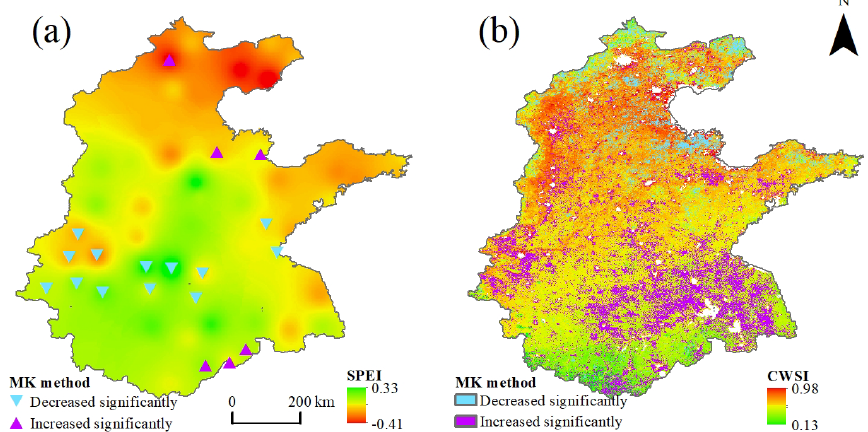
Figure 3. Spatial changes in the SPEI ( a ) and CWSI ( b ) in summer on the North China Plain from 2000 to 2018.